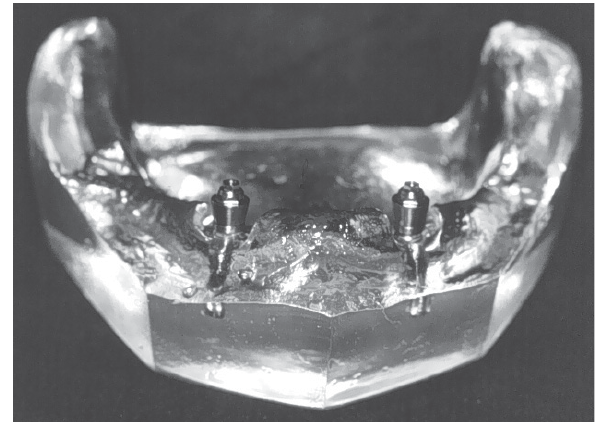
FIGURE 1- Acrylic resin model with two external hex cylinder implants. Abutments were connected to the